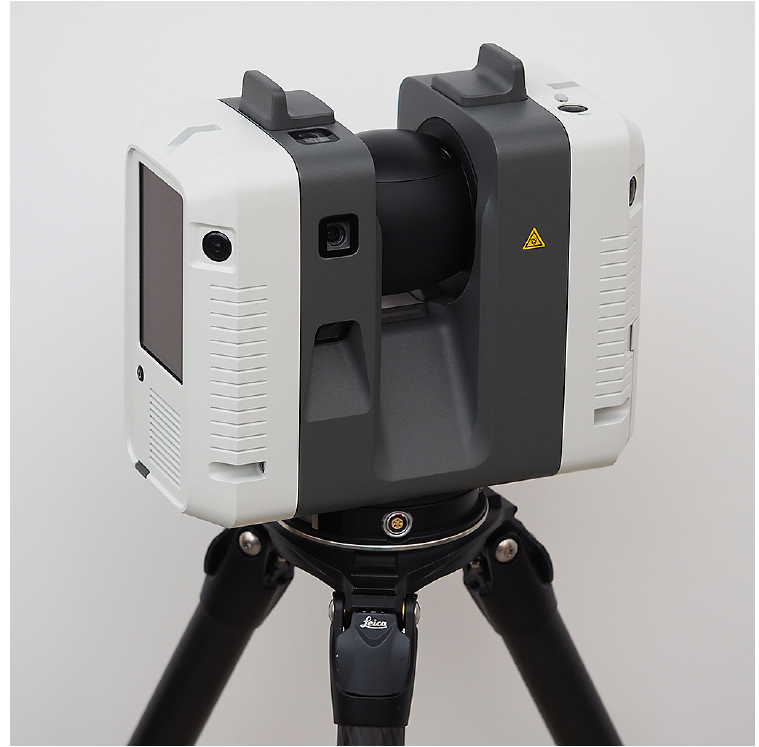
Figure 1. Time-of-flight scanner Leica